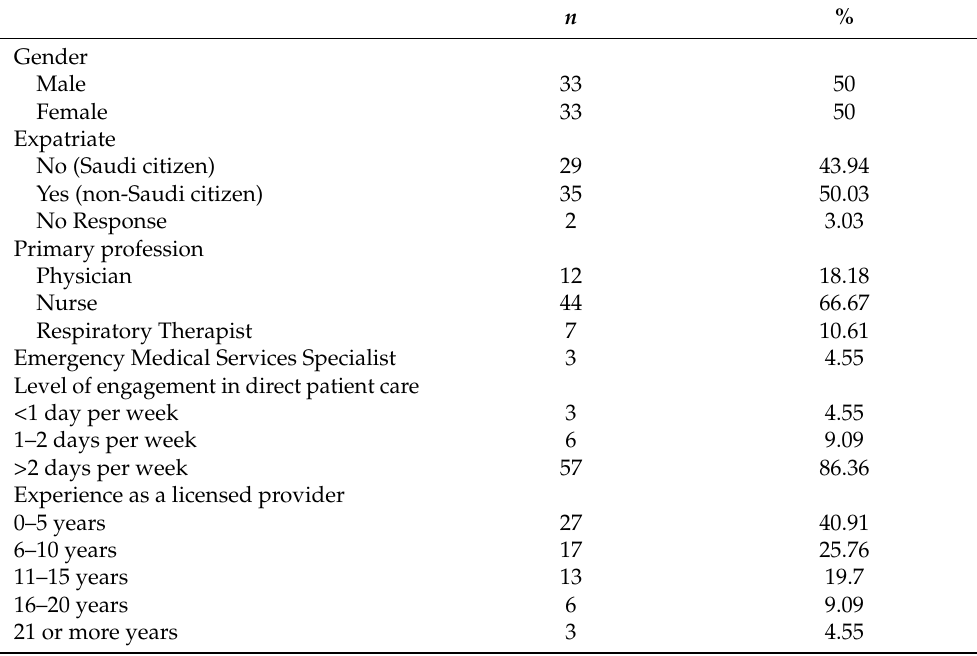
Table 1. Participants’ demographic characteristics, n =